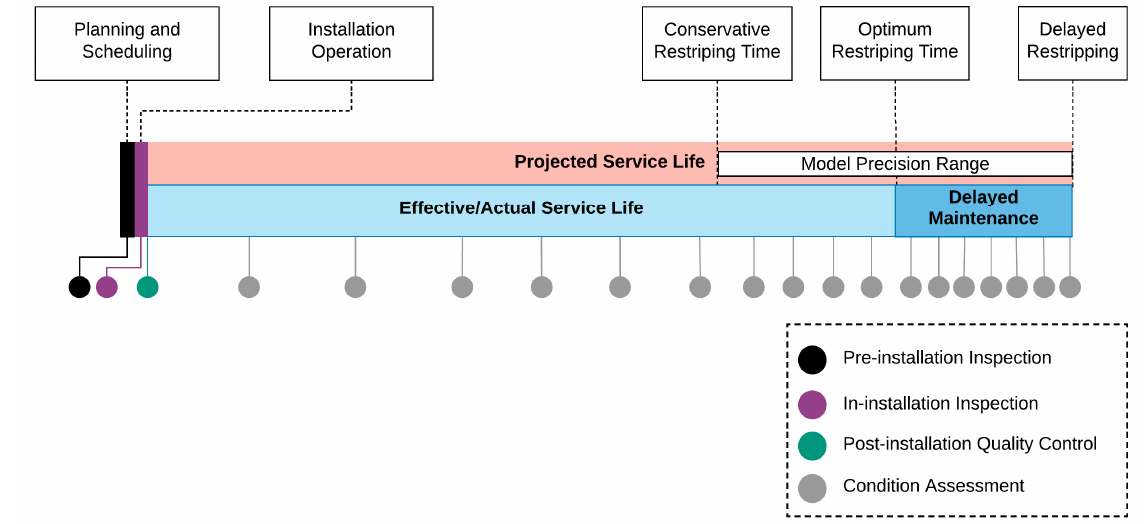
Figure 5. Timeline of pavement marking inspections [the figure is not to the scale].